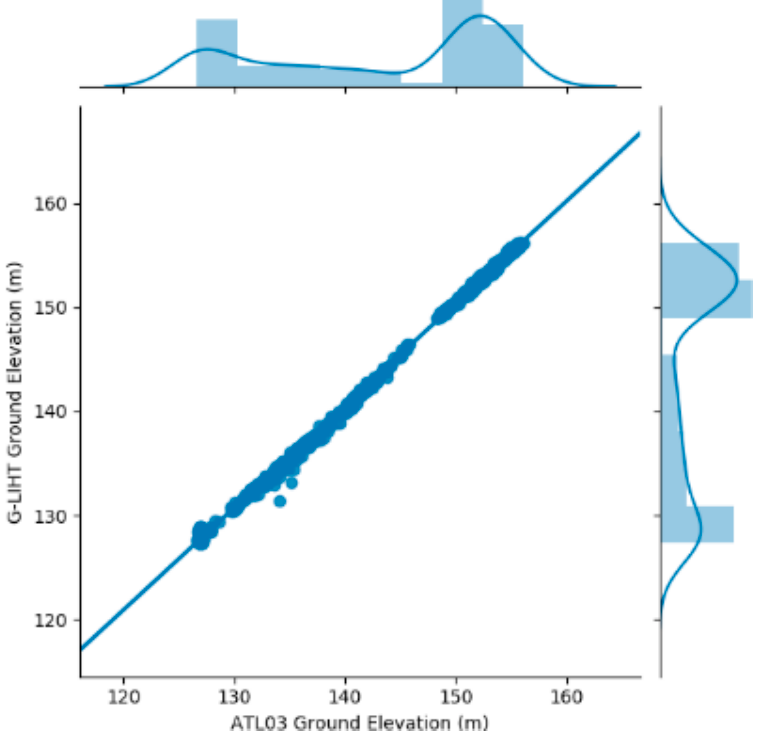
Figure 9. Scatterplot of ATL03 (gt3r) ground topography compared to G-LiHT DTM.